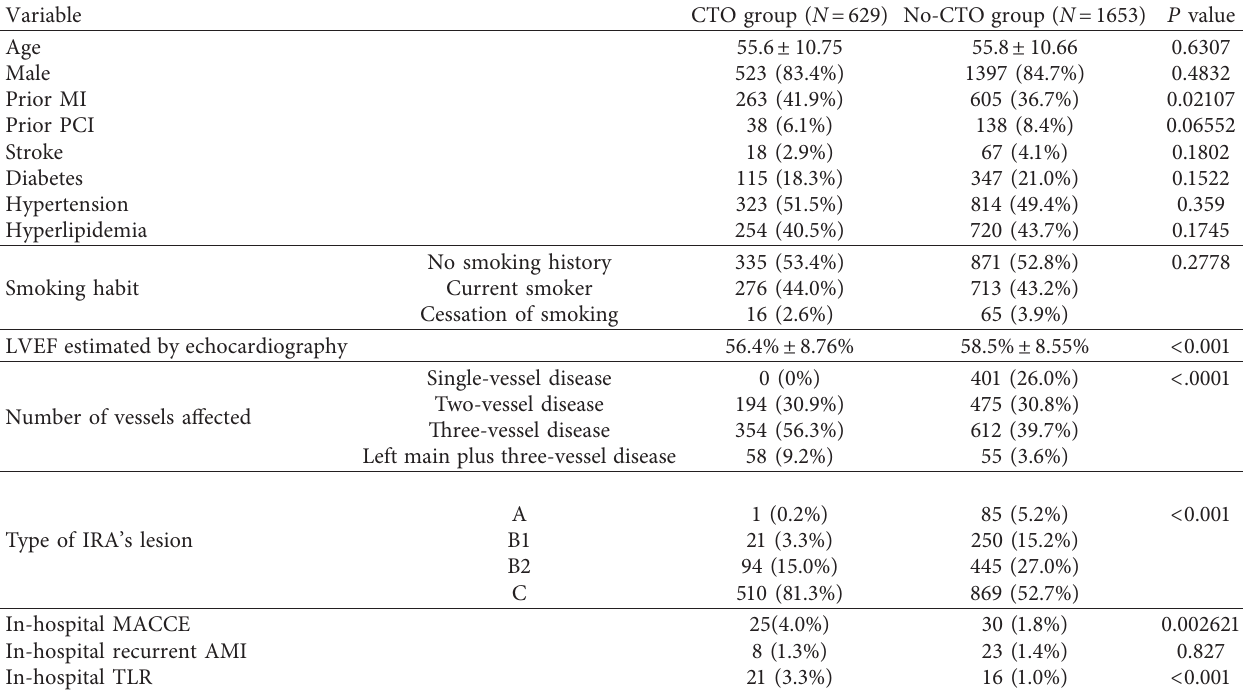
Table 2: Baseline and angiographic characteristics of patients with CTO or without CTO.